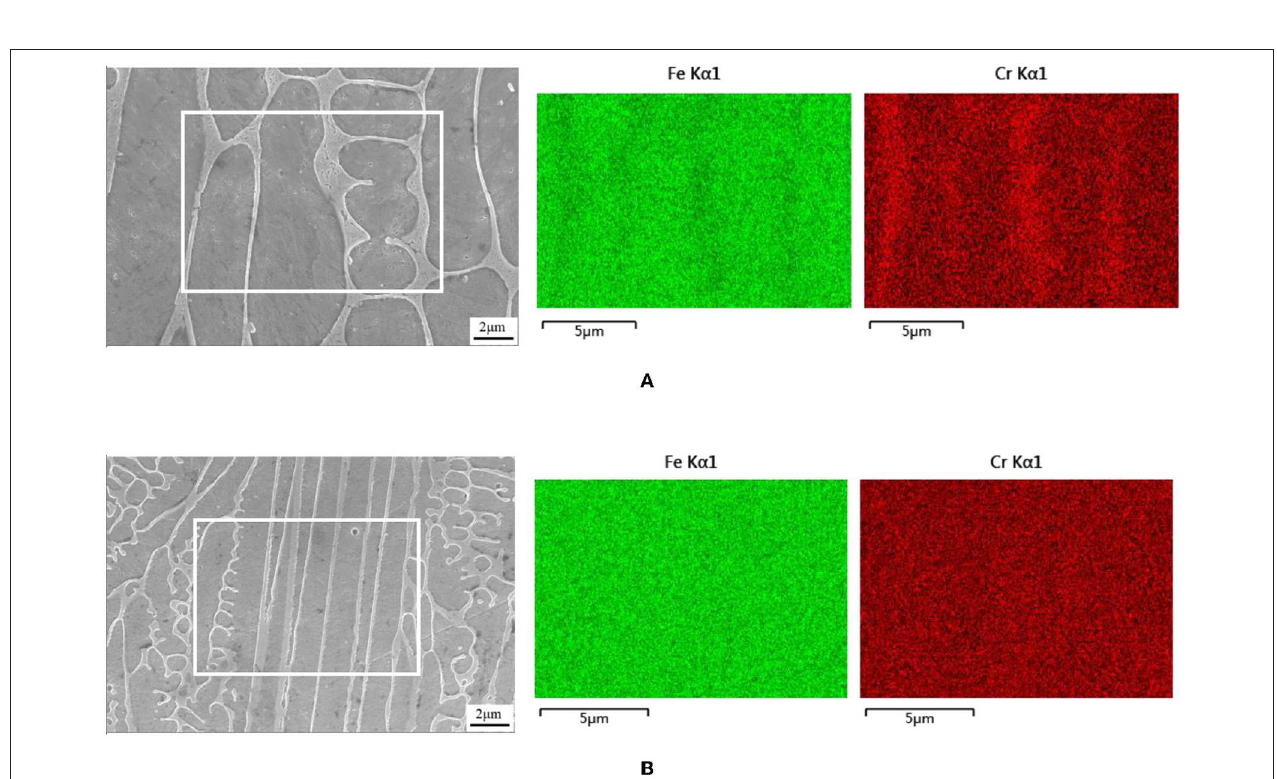
FIGURE 6 | EDS spectral mapping of (A) LMD layer; (B) EHLMD layer.